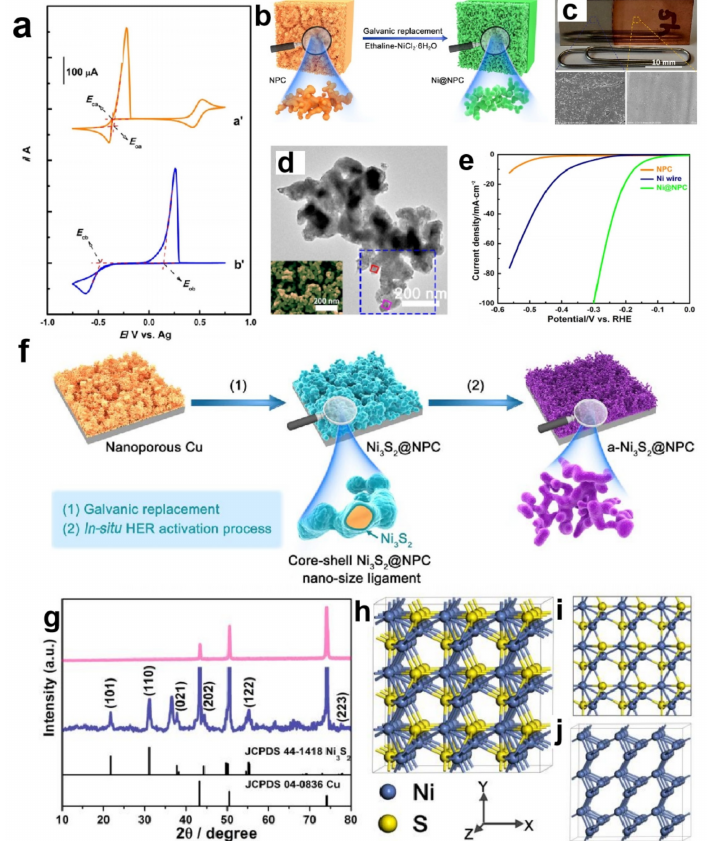
Figure 4. CVs of 0.10 M CuCl 2 · 2H 2 O (a (cid:48) ) and 0.10 M NiCl 2 · 6H 2 O (b (cid:48) ) in ChCl/EG recorded at Pt electrode, respectively ( a ), schematic diagram for the synthesis of Ni nanocrystals ( b ), photographic image for Cu foil before and after replacement for 5 h in 0.10 M NiCl 2 · 6H 2 O/DES and correspond- ing SEM analysis ( c ), HAADF-STEM image ( d ) of Ni nanocrystals, polarization curves ( e ) of Ni nanocrystals and comparative electrocatalysts for HER (Reprinted with permission from Ref. [53], 2016, Elsevier); Schematic illustration showing the fabrication process of Ni 3 S 2 @Cu ( f ), XRD patterns ( g ) of Ni 3 S 2 @Cu (navy line) and bare Cu (pink line), front and top view of Ni 3 S 2 supercell (3 × 3 × 3) shows the crystal structure ( h , i ), network of Ni-Ni bond paths in heazlewoodite Ni 3 S 2 crystallizes ( j ) (Reprinted with permission from Ref. [54], 2017,